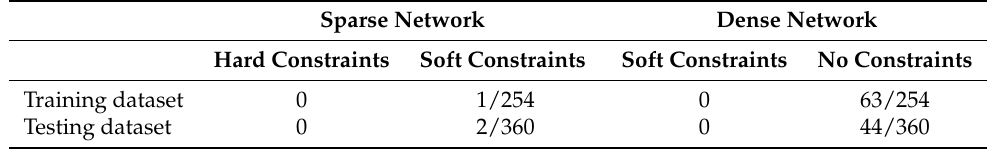
Table 2. The fraction of static arbitrage violations without Dupire penalization.